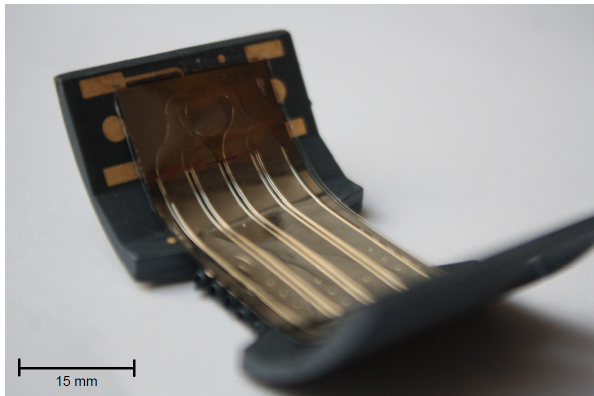
Figure 7. Microfluidic impedance spectroscopy sensor directly at- tached on the 3D-MID carrier.